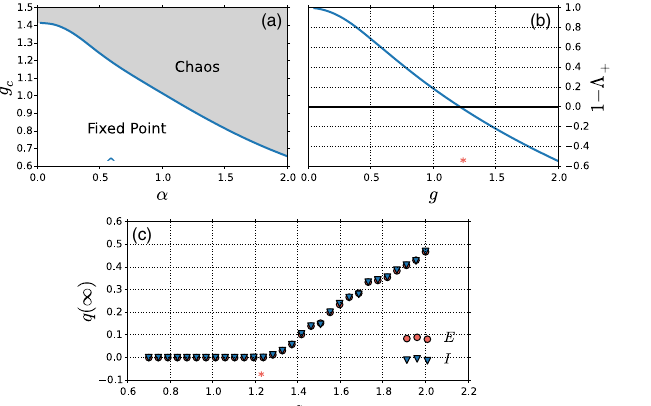
FIG. 6. Transition to chaos in a system of two populations. Parameters used: J